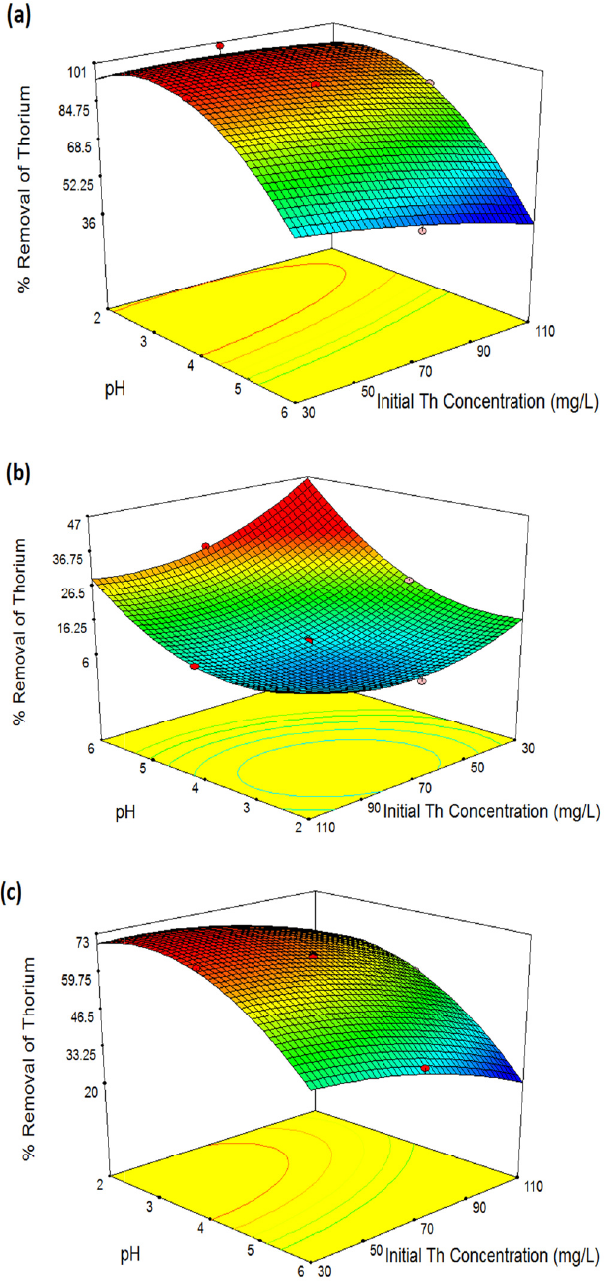
Fig. 2. Three-dimensional plots showing effect of pH and adsorbent dosage [mg.L -1 ] on the removal efficiency of Th(IV) using IR-120 (a), IRA-400 (b) and in combination (c), keeping initial Th(IV) ion concentration 70 mg.L -1